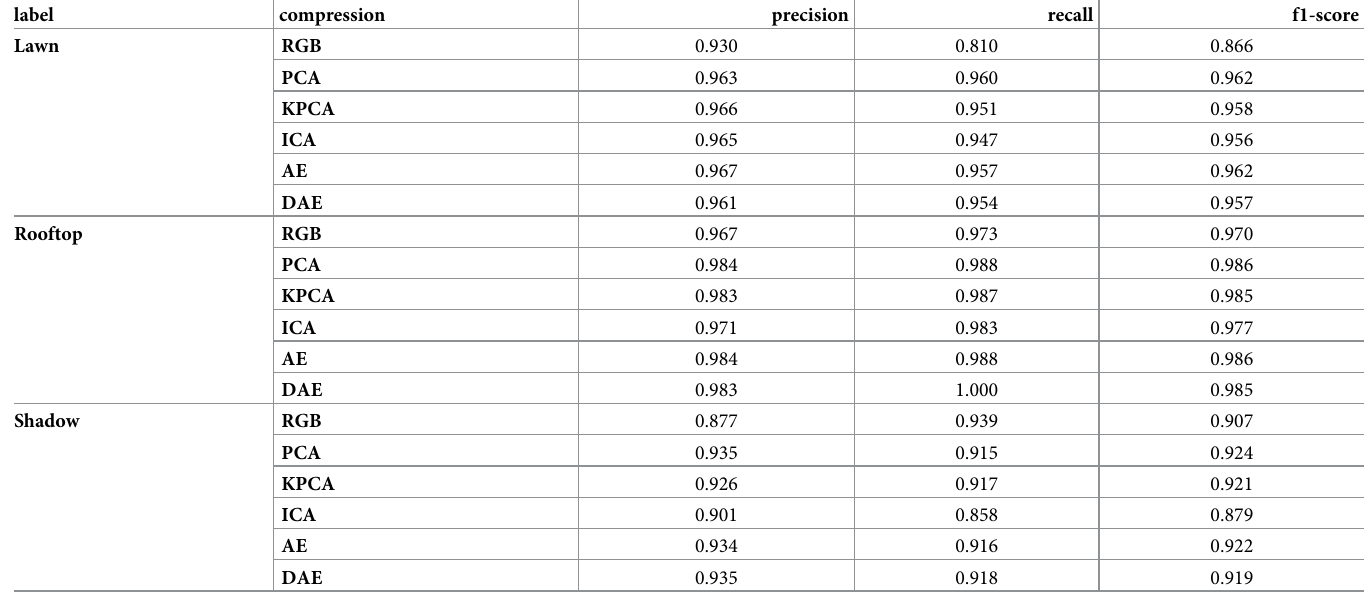
Table 5. Top classification scores Urban, HSI, compression rate =